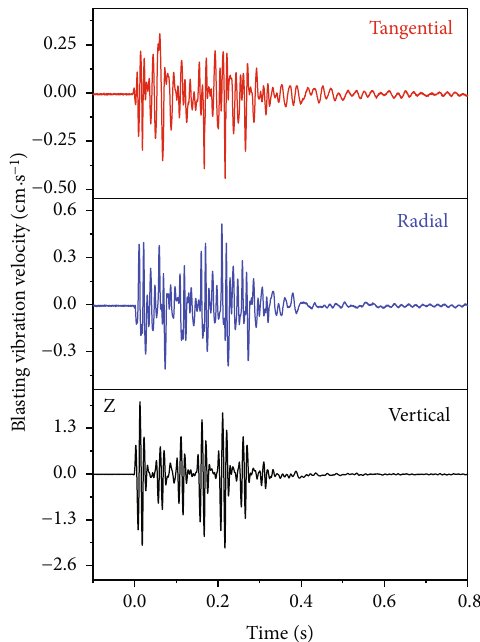
Figure 5: Time-history waveform of the blasting vibration of the